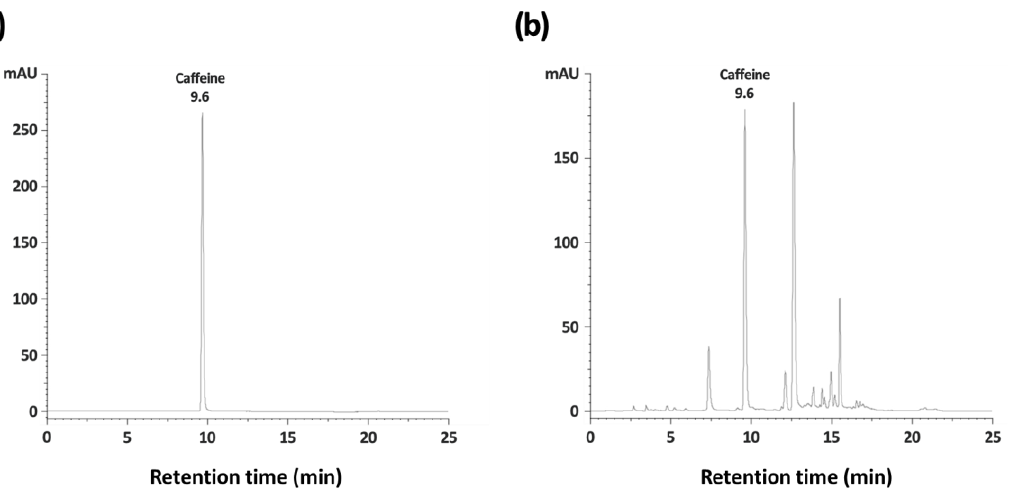
Figure 8. HPLC analysis chromatogram of caffeine standard ( a ) and GT ( b ). GT, green tea ethanol extract.